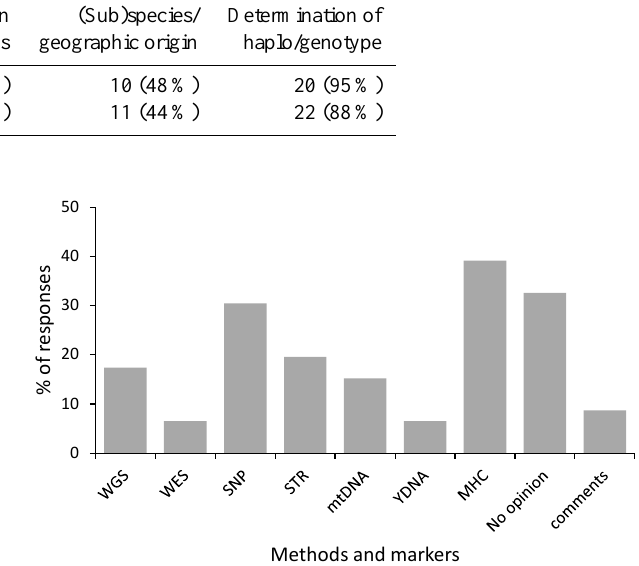
Figure 5. Preferred genotyping methods and markers according to responses ( N = 46). WGS: whole-genome sequencing; WES: whole-exome sequencing; SNP: single-nucleotide polymorphisms; STR: short tandem repeats; mtDNA: mitochondrial DNA; YDNA: Y chromosomal DNA; MHC: major histocompatibility